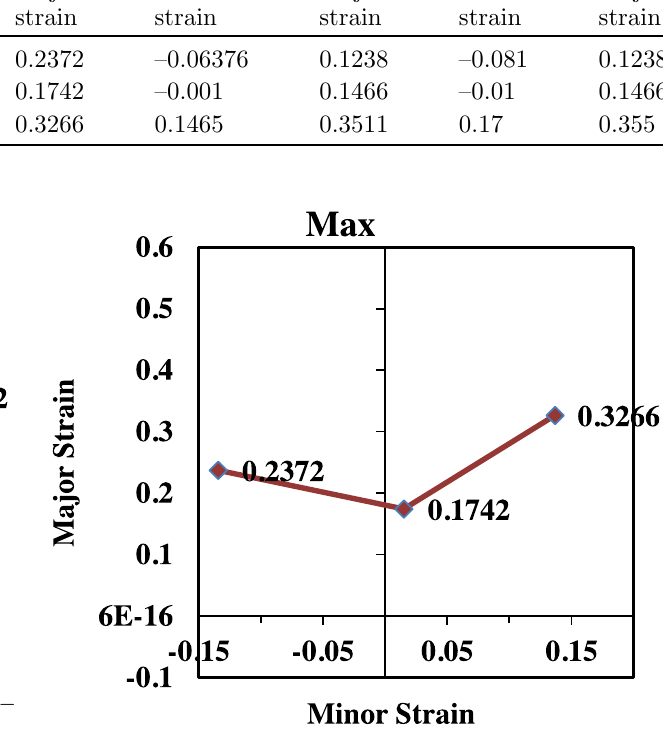
Fig. 17. Forming limit diagram for rotated cube – numerical simulation.